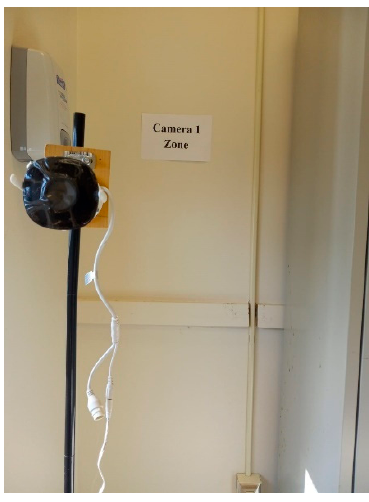
Figure 5. Placement of multiple proximity sensors in the ‘study-zone’.